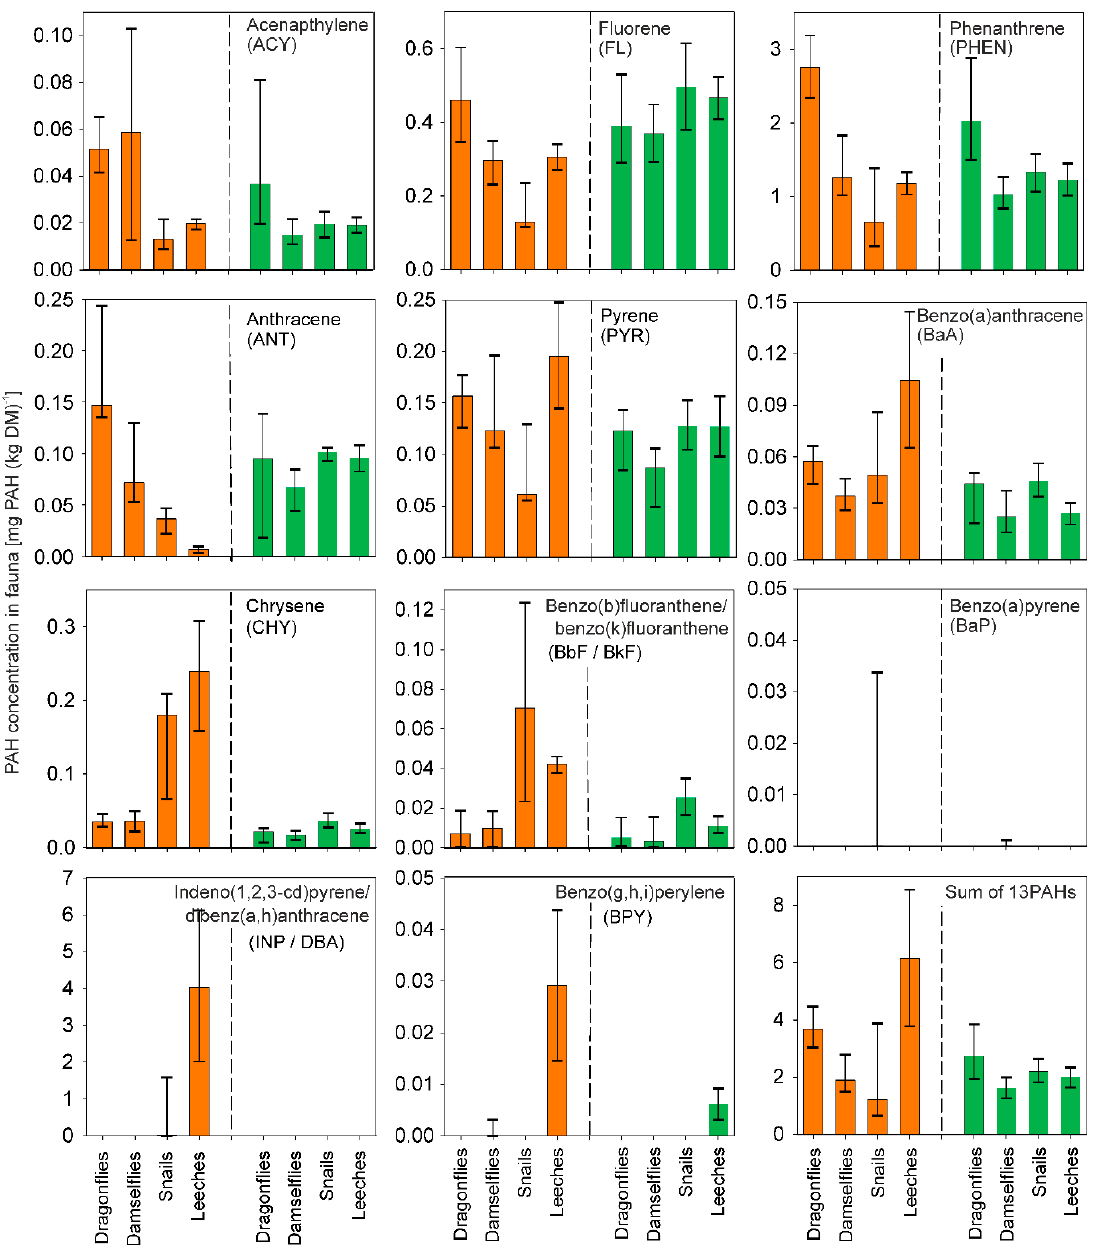
Figure 3. Median PAH concentrations in invertebrates in the SWRPs (orange bars) and the natural, shallow lakes (green bars). Nomenclature: damselfly (median concentration calculated on 4 pond samples/6 lake samples); dragonfly (8 pond samples/12 lake samples); snails (9 pond samples/2 lake samples); leech (2 pond samples/2 lake samples).